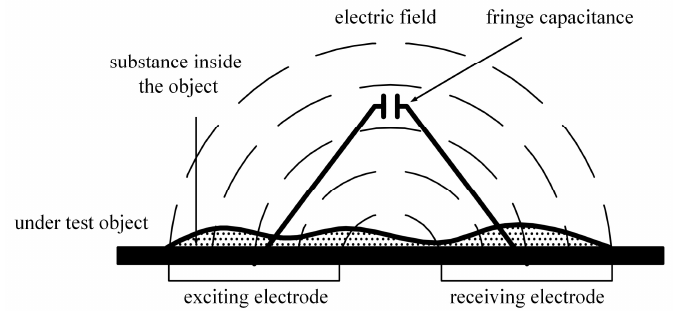
Figure 2. The working principle of the coplanar capacitive sensor.